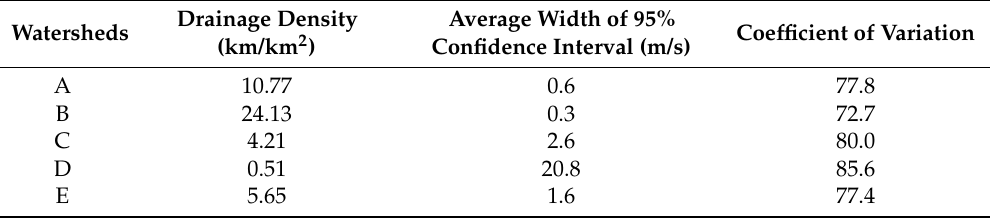
Table 4. Results of drainage density